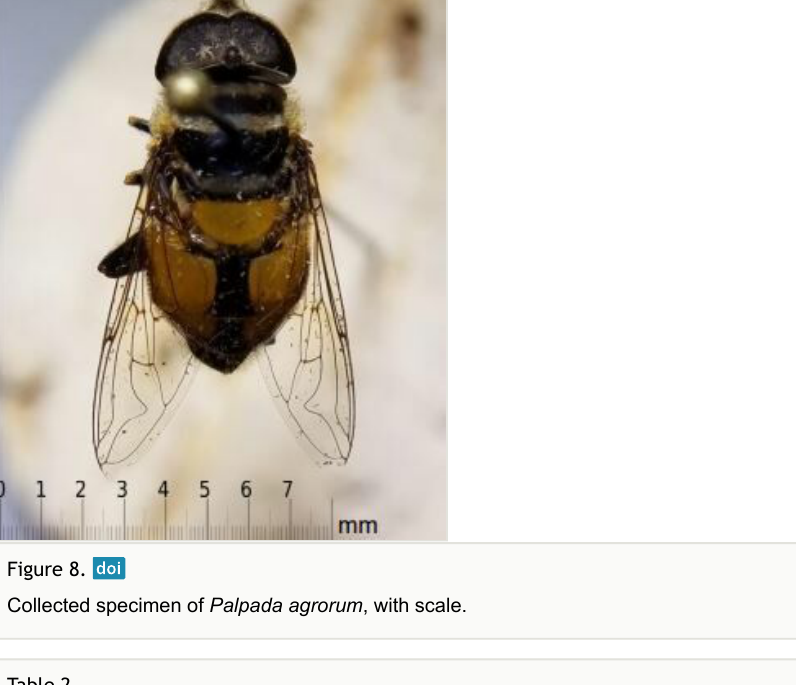
Table 2. List of all floral taxa from which syrphids were collected. Plant species codes (as reported in Table 1) are comprised of the first three letters of the genus and specific epithet, and family codes are comprised of the first four letters of the family name. Floral associations were occasionally identified only to genus level, and these are reported in Table 1 as the first three letters of the genus name (except Tradescantia and Tragopogon , for which the first four letters are Taxon Taxon Code # syrphid specimens collected from # syrphid species collected from Pan Trap 323 28